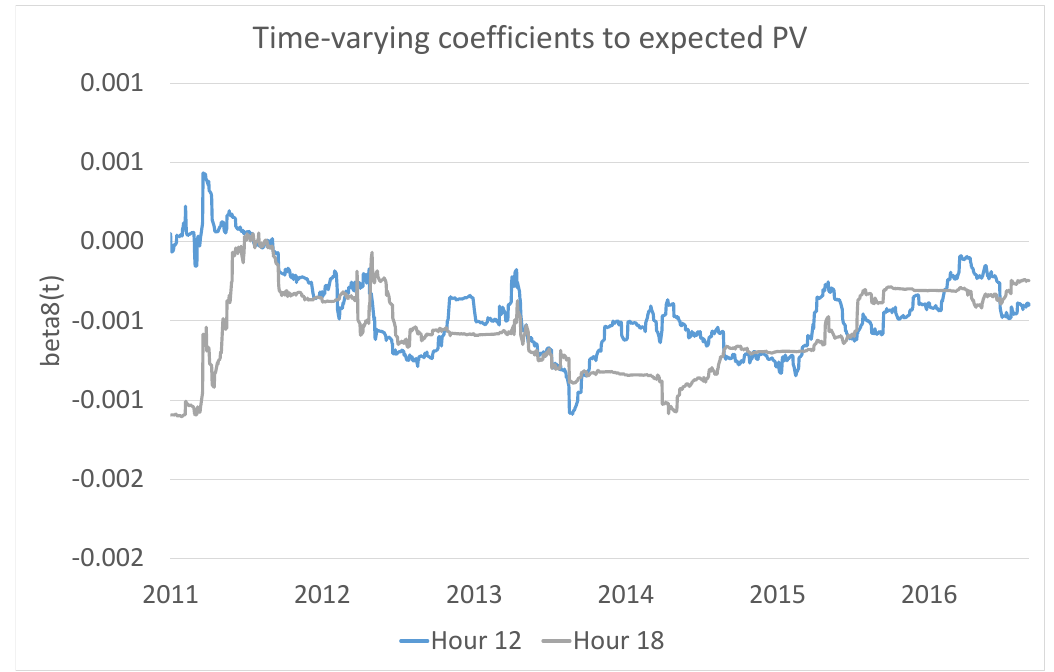
Figure 9. Time-varying coefficients of German wind and PV infeed. The coefficients have been estimated for the sample period from 1 January 2011 until 31 August 2016 with respect to the key hours H4, H12 and H18 on working